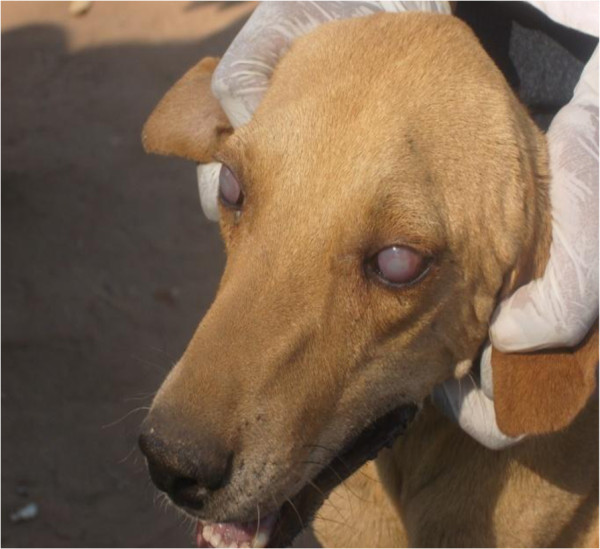
Clinical examination of an indigenous dog showing evidence of bilaterial corneal opacity.